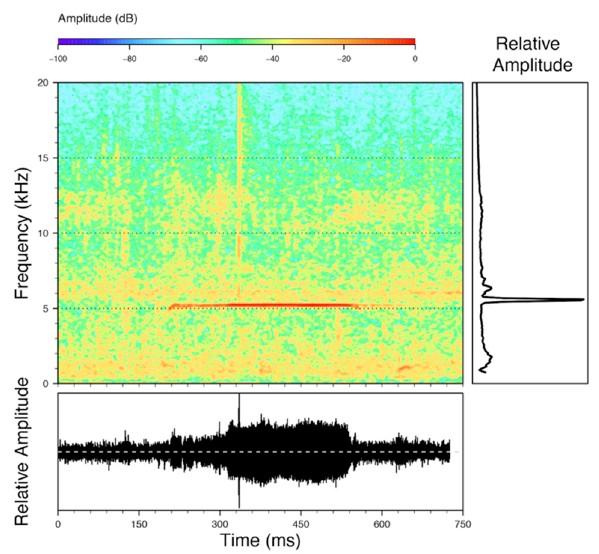
Figure 125. Call of Hyalinobatrachium yaku from Kallana, 325 m, Pastaza province, Ecuador; holotype, MZUTI 5001.